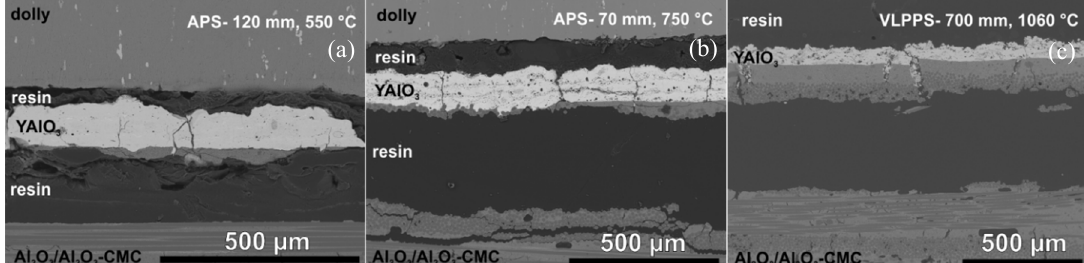
Figure 8. SEM images of the APS YAlO 3 coatings sprayed at 120 mm ( a ) and 70 mm ( b ) and of the